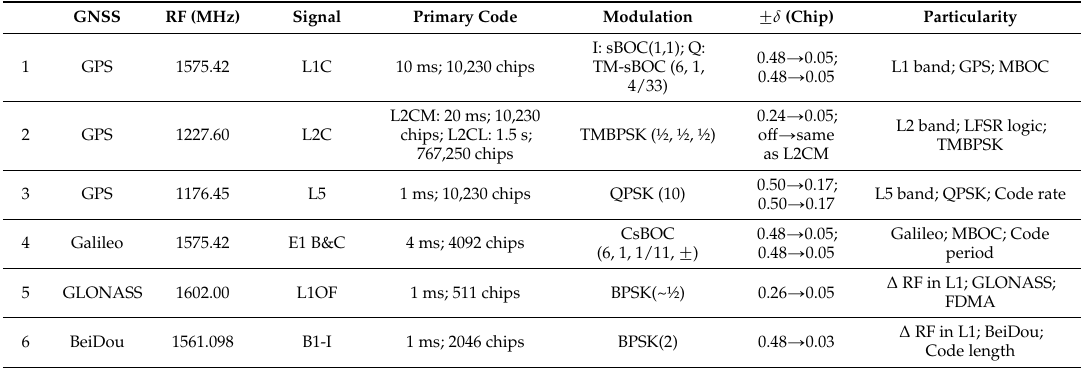
Table 4. Proposed Universal Channel Test